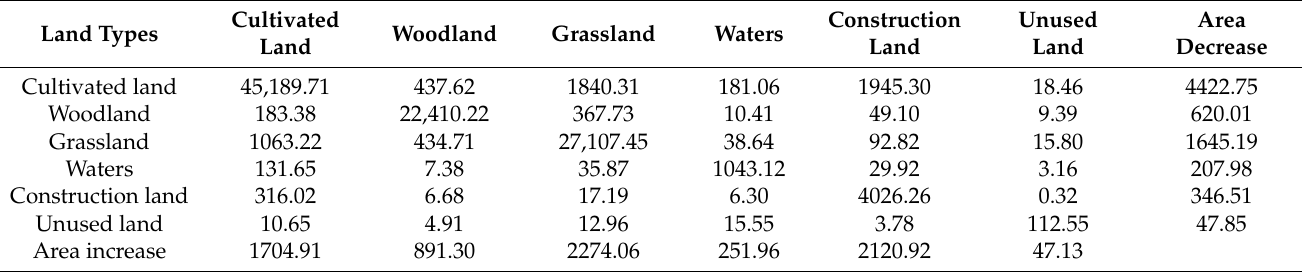
Table 5. Land-use transition matrix of Guanzhong Plain urban agglomeration from 2000 to 2020 (km 2